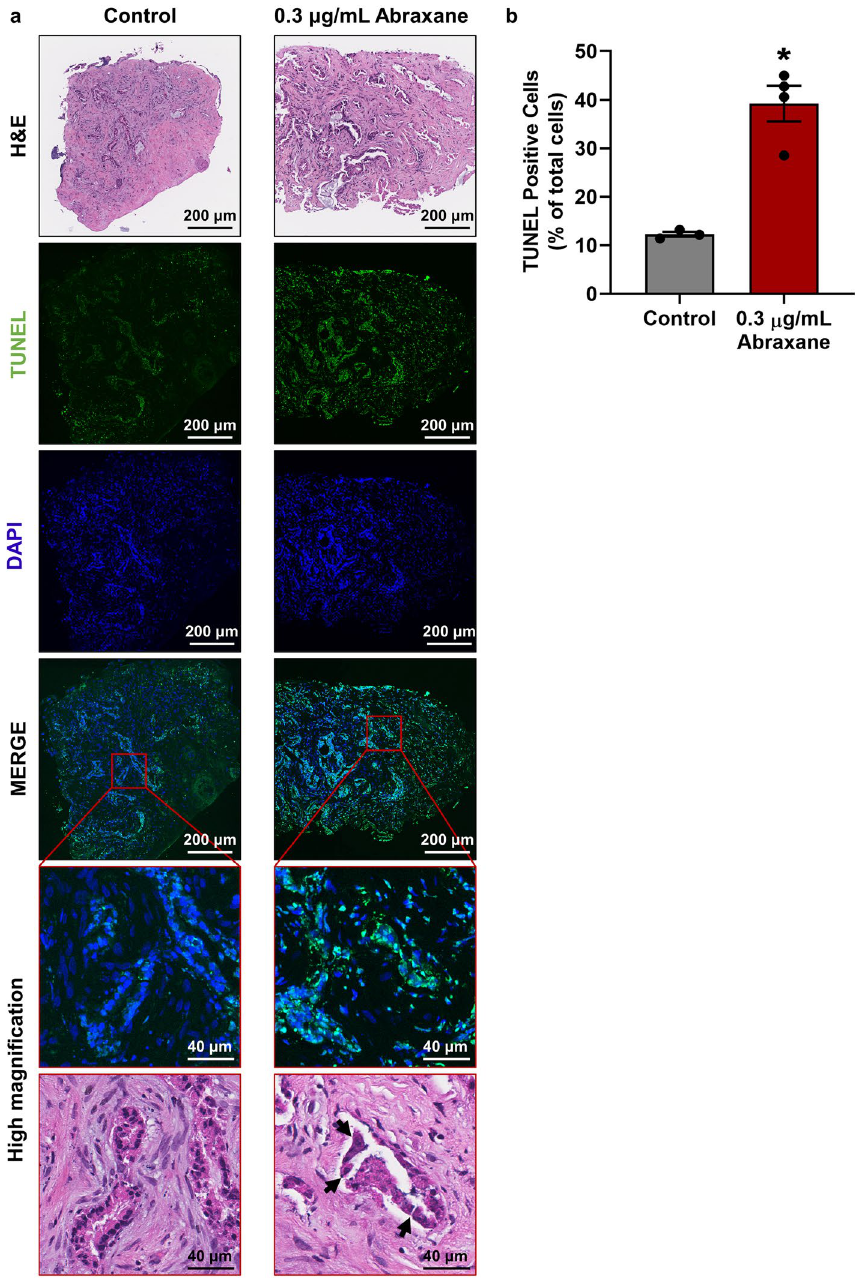
Figure 7. Testing of clinical therapeutics in human patient derived pancreatic ductal adenocarcinoma explants. (a) Tumour explants from patient 2 were treated with or without 0.3 μg/mL Abraxane on days 0, 3, 6 and 9, then fixed on day 12. TUNEL staining was performed to assess levels of cell death. Black arrows in H&E stained sections point to areas of ductal fragmentation in Abraxane treated explants. (b) Quantification of TUNEL positive cells using QuPath demonstrated increased cell death in Abraxane treated explants compared to untreated controls. A paired t-test was performed to compare TUNEL-positivity in control vs Abraxane treated explants from a single patient, with 3–4 explants per treatment from distinct regions of the patient’s tumour (represented by each dot in the bar graph). Bars represent mean ± S.E.M., *p =